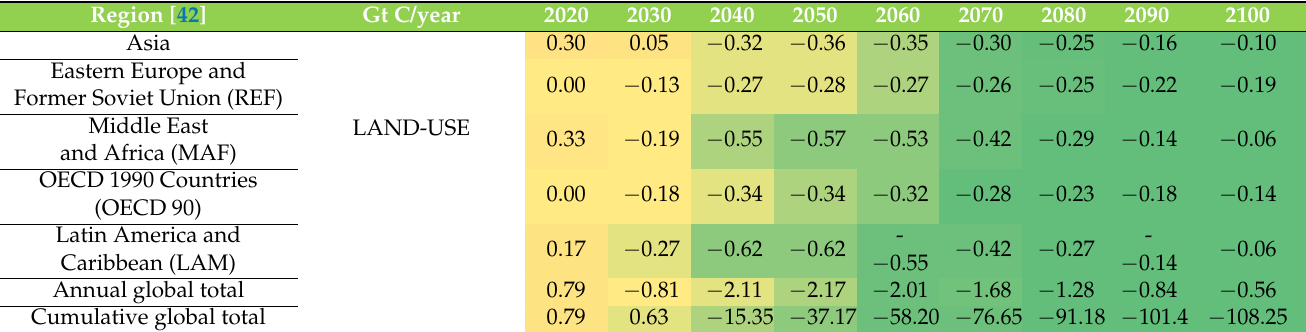
Table 4. Net carbon mitigation from land-use management pathways for 1.5 ◦ C: 2020–2100. Region